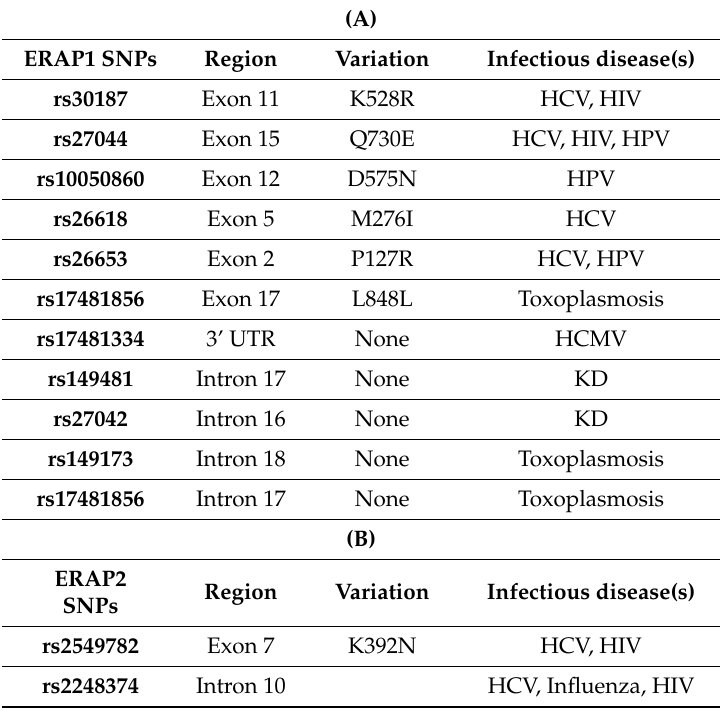
Table 1. A list of endoplasmic reticulum aminopeptidase 1 (ERAP1) ( A ) and ERAP2 ( B ) sequence variants involved in infectious